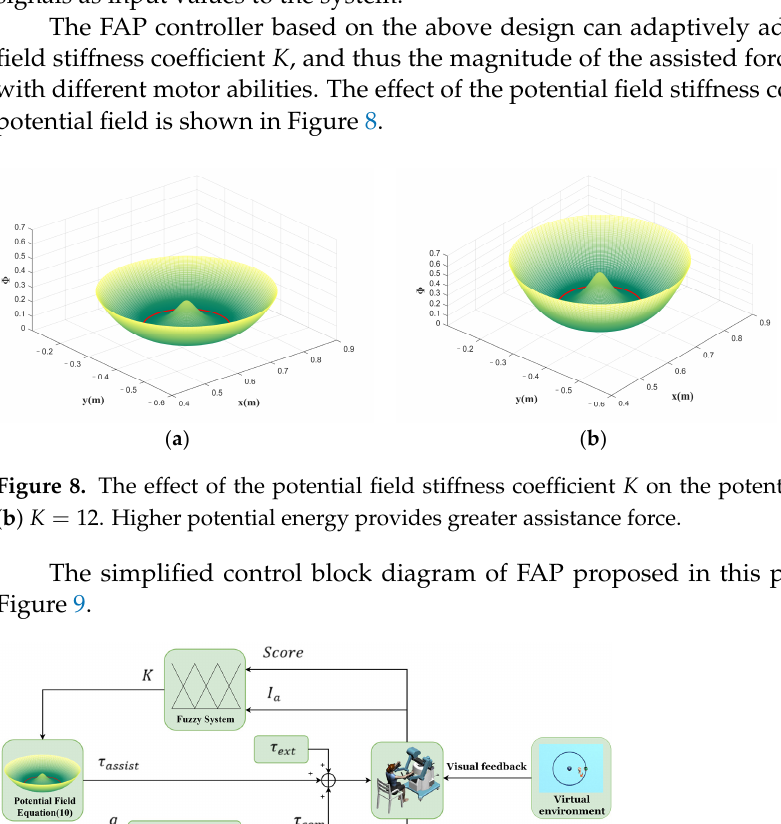
Figure 9. The simplified control block diagram of